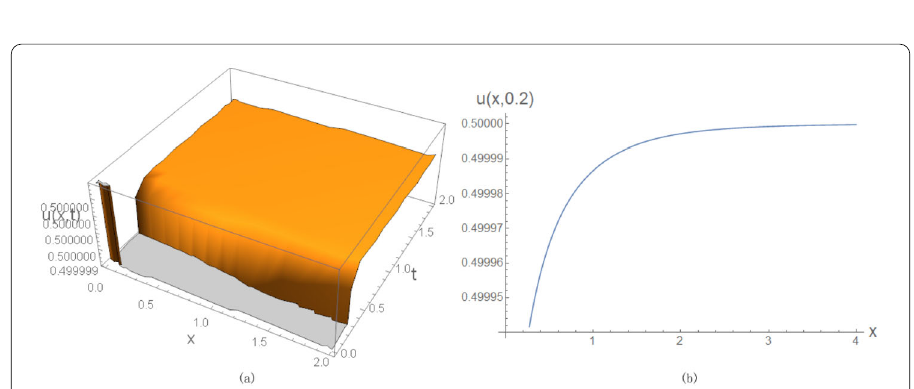
Figure 9 ( a ) Three-dimensional figure of (77), when κ = 1, c = – 25 two-dimensional figure when t = 0.2